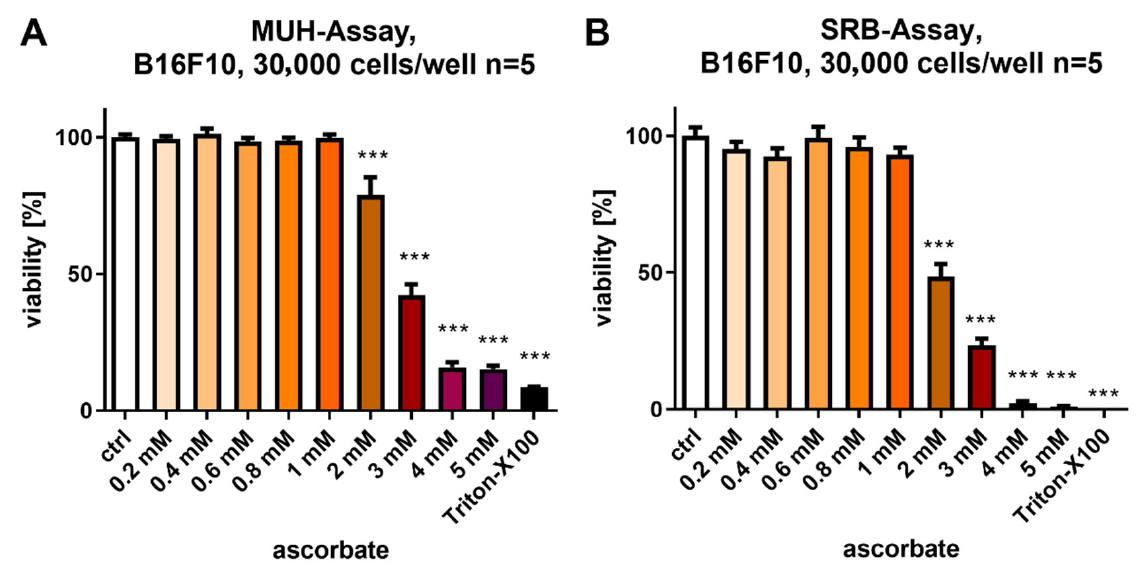
Figure 1. Ascorbate-induced growth inhibition on murine melanoma cells. ( A ) B16F10 mouse melanoma cells were exposed to varying amounts of ascorbate (0–5 mM). The viability of murine melanoma cells was evaluated using the MUH assay in comparison to the medium-treated control. Depicted are the mean values ± SD of five standalone experiments, measured in duplicate, respectively, and standardized to the medium-treated control. ( B ) B16F10 mouse melanoma cells were exposed to varying amounts of ascorbate (0–5 mM). The cell viability was assessed using the SRB assay in comparison to the medium-treated control. Depicted are the mean values ± SD of five standalone experiments, each measured in duplicate and standardized to the medium-treated control. ***: p ≤ 0.001. MUH, 4-methylumbelliferyl heptanoate; SD, standard deviation; SRB, sulforhodamine B.